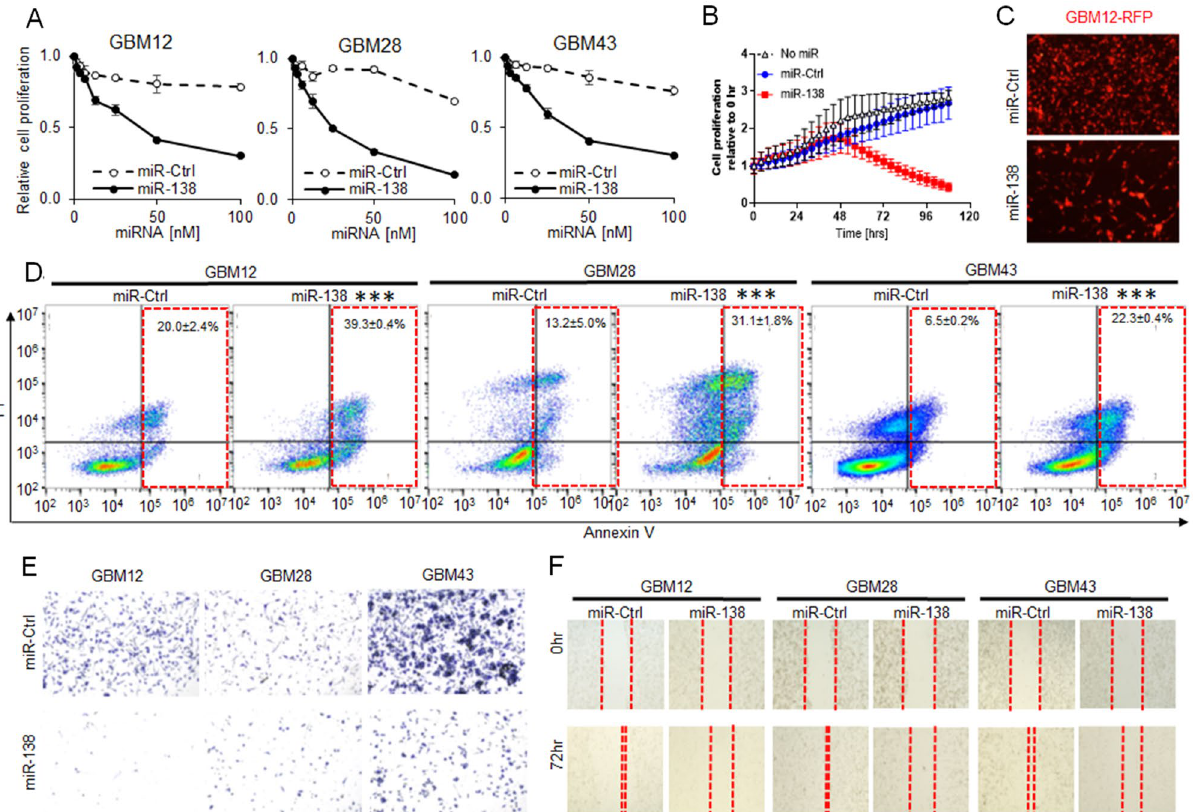
Figure 2. Overexpression of miR-138 inhibits cell proliferation and migration in vitro. ( A ) GBM cell proliferation with miR-138 overexpression. Patient-derived primary GBM cells (GBM12, 28 and 43) were transfected with a series of concentration of miR-138 mimics or negative control (miR-Ctrl). After 4 days of transfection, viable cells were measured by CellTiter-Glo Luminescent Cell Viability Assay. ( B ) Cell proliferation analysis by fluorescence live cell imaging every four hours on GBM12-RFP cells after transfection of 25 nM miR- 138 or miR-Ctrl. ( C ) Representative fluorescence images of GBM12-RFP cells at 96 h after transfection of 25 nM miR-138 or miR-Ctrl. ( D ) Apoptosis analysis on GBM cells (GBM12, 28 and 43) after transfection of 25 nM miR-138 or miR-Ctrl followed by Annexin V-PI double staining for flow cytometry. Percentage of apoptotic cell populations were indicated in red-dotted box on each representative cytograms (n = 3). ( E ) Cell migration assay in Trans-well chamber plates. GBM cells transfected with 25 nM miR-138 or miR-Ctrl were cultured in 8 µm pore size Boyden chamber inserted into 24-well plates. The top chamber was removed 4 days later, and the migrated cells in the bottom chamber were visualized by staining with 0.5% crystal violet. Each images represent stained cells from each well obtained by bright field microscope. ( F ) Wound healing assay to evaluate the change of physical gap-closure by miR-138 overexpression. At Day 0, monolayer of GBM cells were scratched vertically followed by transfection of 25 nM miR-138 or miR-Ctrl. Representative cell images were taken at 4 days later by bright field microscope. All error bars indicates standard deviations (n = 3), and the p -values were determined by two-tailed student t -test. *** p <